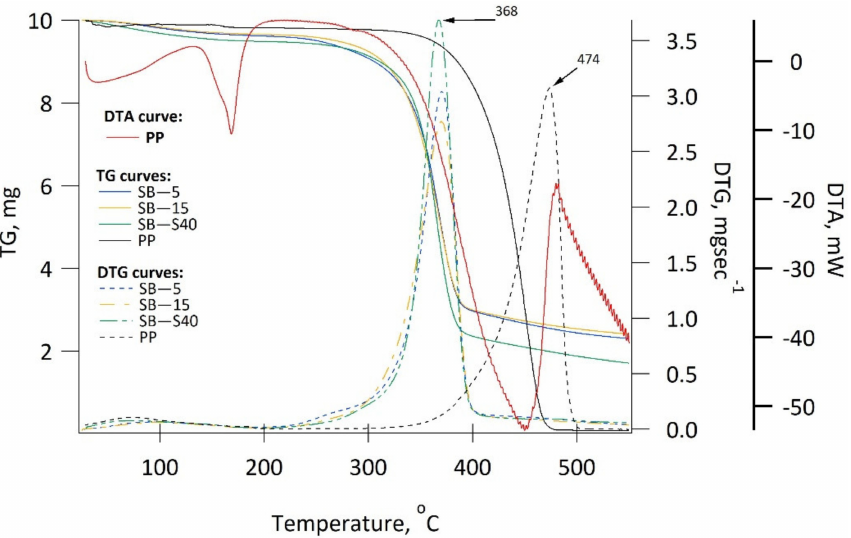
Figure 3. TG/DTG curves of SB-5, SB-15, SB-S40, and PP